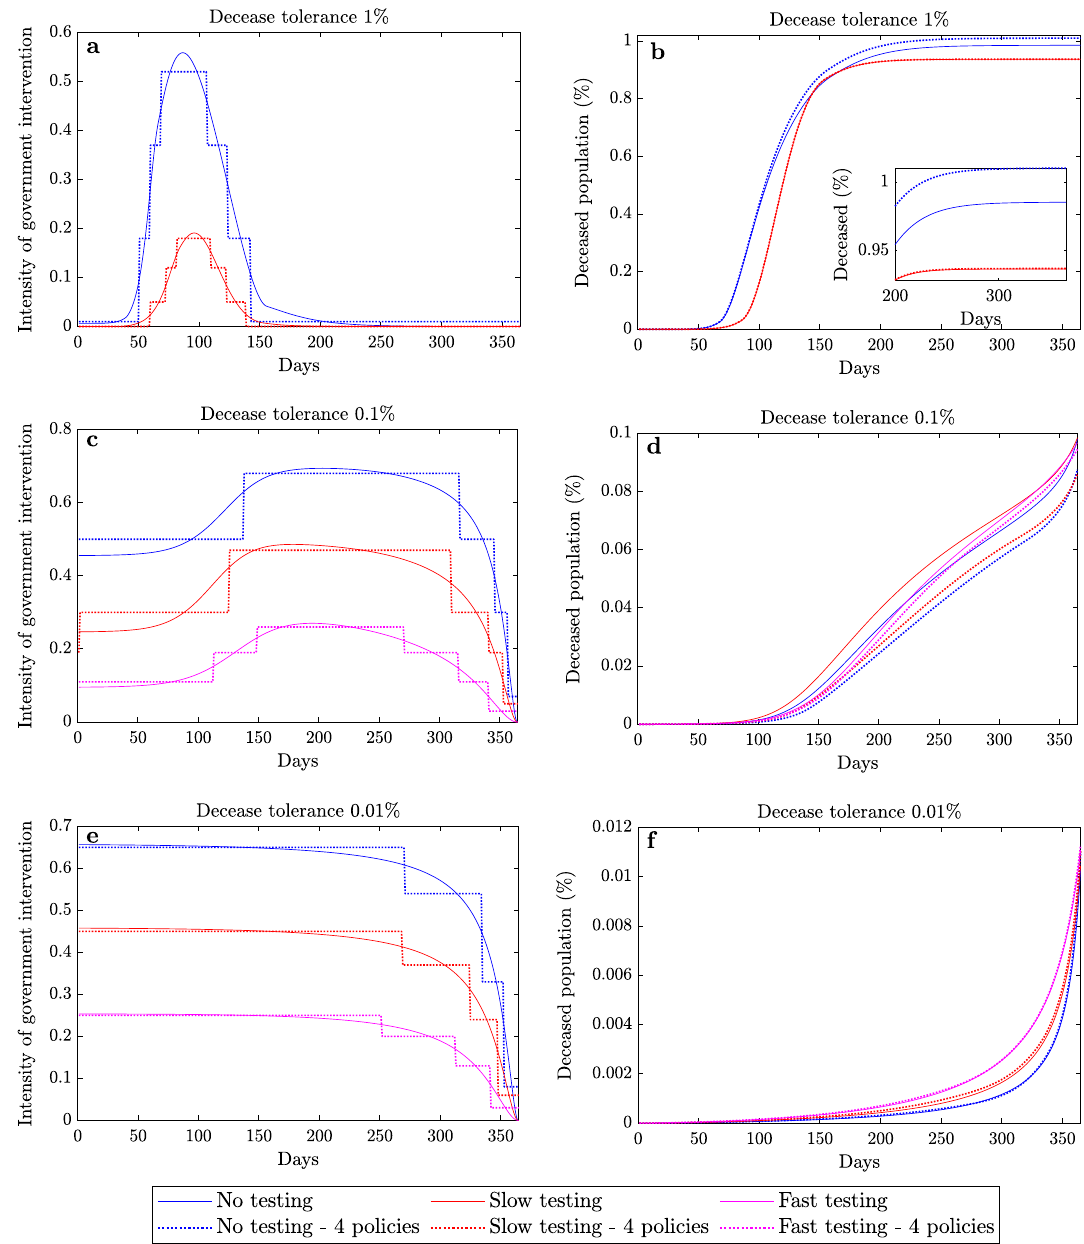
Figure 3. Optimal intervention strategies and deceased population. Optimal government intervention strategy ( a,c,e ) and proportion of deceased population ( b,d,f ) versus time for government strategies with 1% decease tolerance ( a,b ), 0.1% decease tolerance ( c,d ) and 0.01% decease tolerance ( e,f ) when (i) no testing (blue), (ii) slow testing (red) and (iii) fast testing (magenta) policies are adopted. The intensity of government intervention strategies corresponds to the strictness of government policies, where 0 corresponds to no interventions and 1 to the strictest possible intervention (e.g. a full scale lockdown). The approach to obtain the optimal continuous strategy is explained in the SI. Dotted plots correspond to optimized discrete implementations of the selected strategies by allowing a maximum of 4 policy levels and 6 policy changes. The distinct policy levels and the times where the policies changed were selected in an optimized way, as described in the “Methods” section and the SI (see Optimal control methodology, Algorithms 1 and 2 and Supplementary Figs. S1, S2). Implementations with 7 and 10 policy levels and 12 and 18 policy changes are presented in the SI (Supplementary Figs.